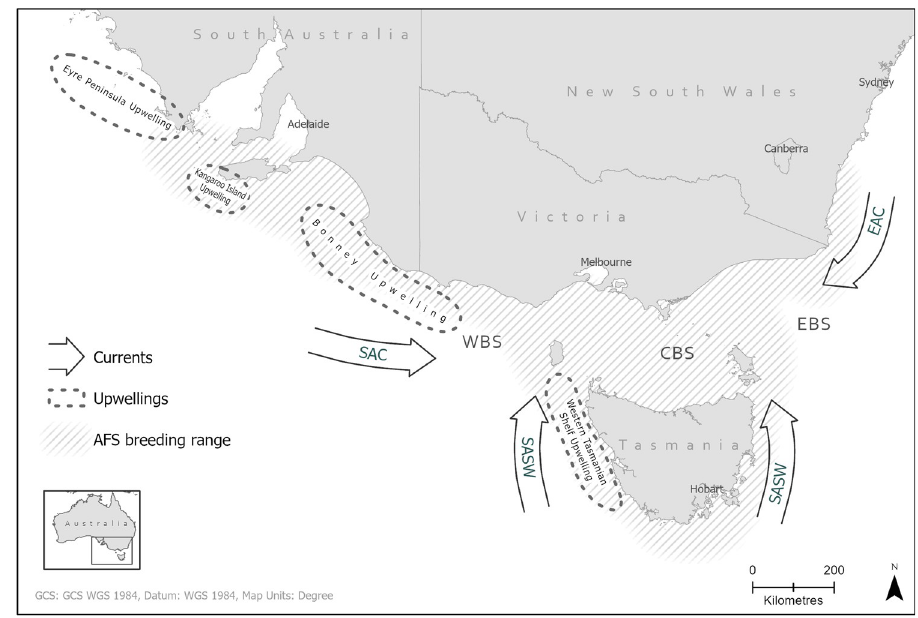
Fig 1. Map of south-eastern Australia showing the breeding range of the Australian fur seal (shaded) [15] and the regional oceanographic influences (currents and cold-water upwellings) [16–18]. Currents and regions are shown by their acronyms: South Australian Current (SAC), Sub-Antarctic Surface Waters (SASW), East Australian Current (EAC), Western Bass Strait (WBS), Central Bass Strait and Eastern Bass Strait (EBS). Geopolitical states (South Australia, Victoria, New South Wales and Tasmania) and associated capital cities are provided for reference. The data in this map is from Geoscience Australia [19].